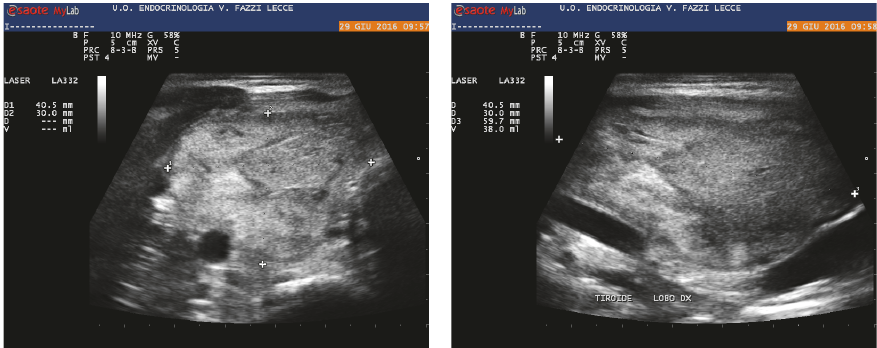
Figure 2: Right lobe thyroid nodule after six percutaneous ethanol injections.